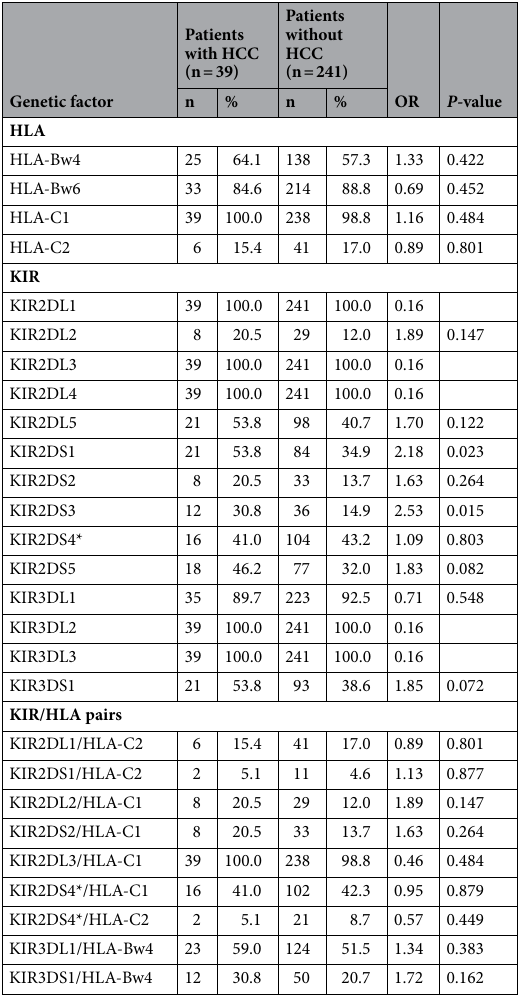
Table 3. Frequency of HLA alleles, KIR genes, and KIR/HLA pairs in patients with and without HCC. HLA human leukocyte antigen, KIR killer immunoglobulin-like receptor, HCC hepatocellular carcinoma, OR odds ratio. *Full-length KIR2DS4 was genotyped.